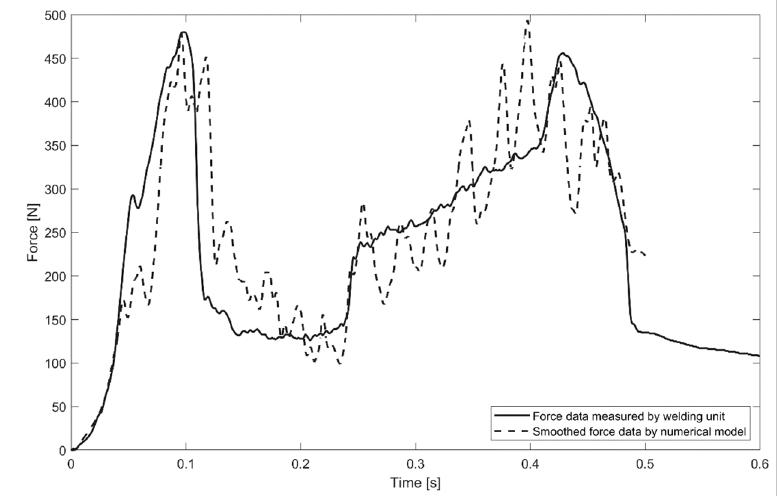
Figure 8. Numerically modelled and experimentally measured reaction force of the sonotrode.